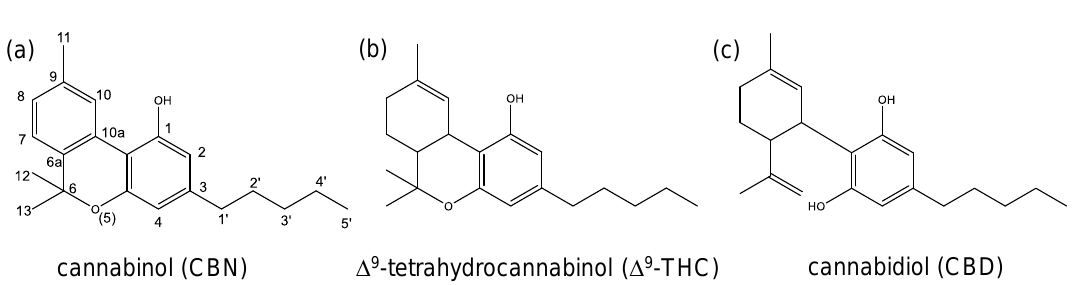
Figure 1. Chemical structures of ( a ) cannabinol (CBN) including the numbering system, ( b ) Δ 9 -tetrahydrocannabinol (Δ 9 -THC) and ( c ) cannabidiol (CBD).